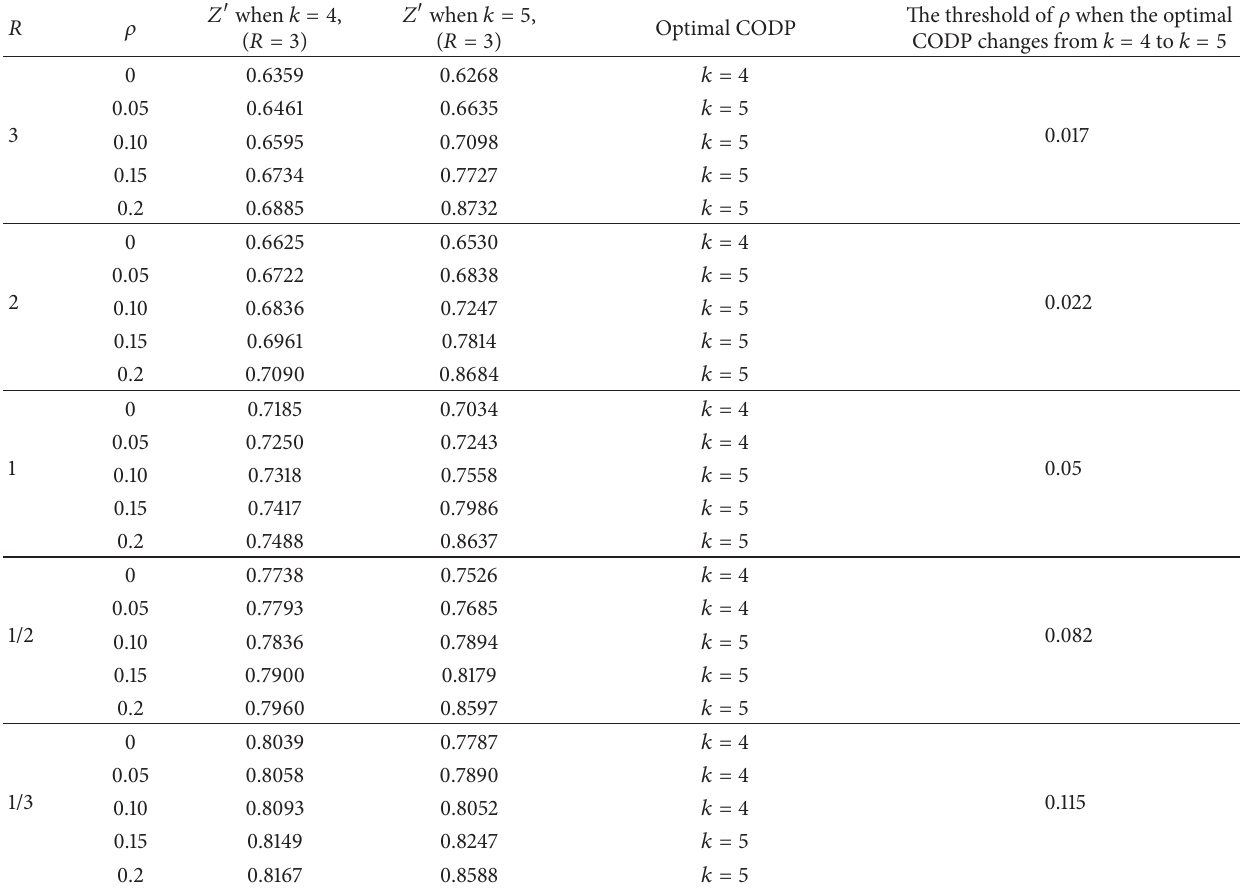
Table 9: The influence of 𝜌 on the scheduling results when 𝑅